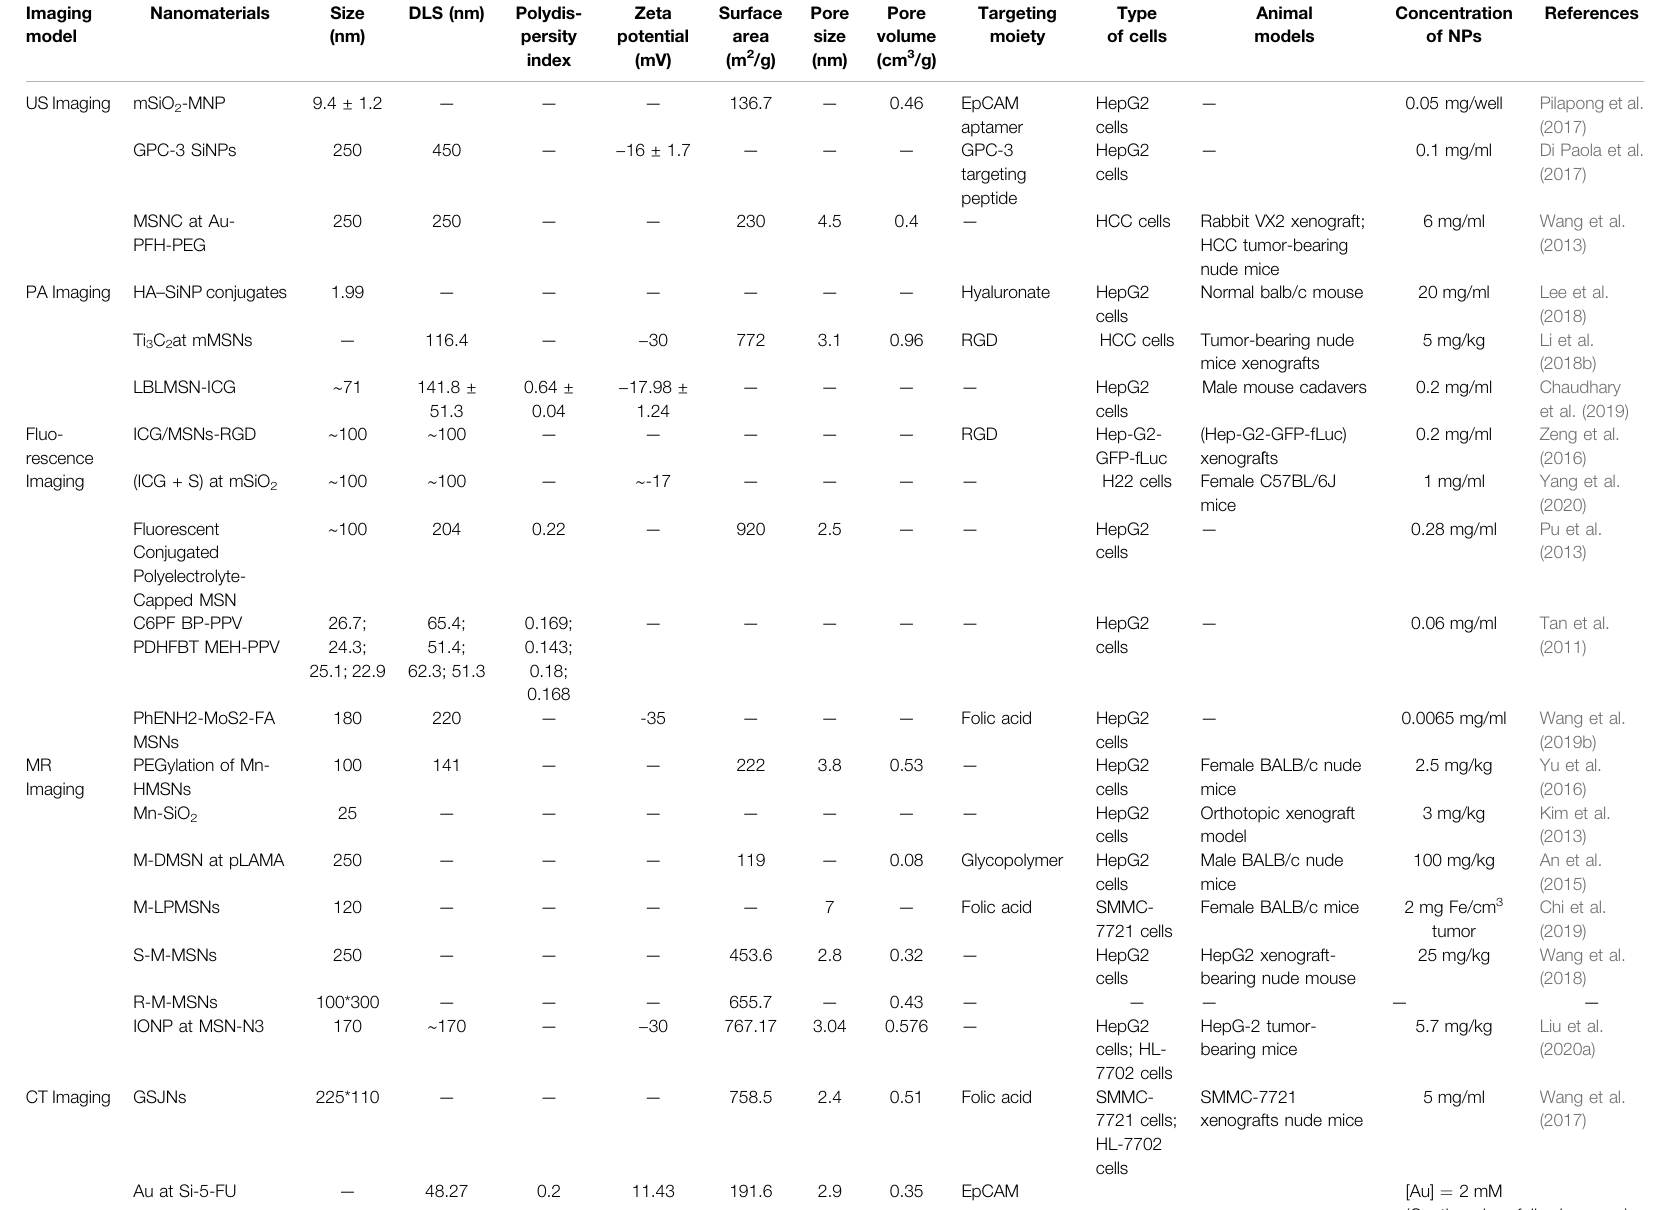
TABLE 1 | MSNs-based nanomaterials for HCC